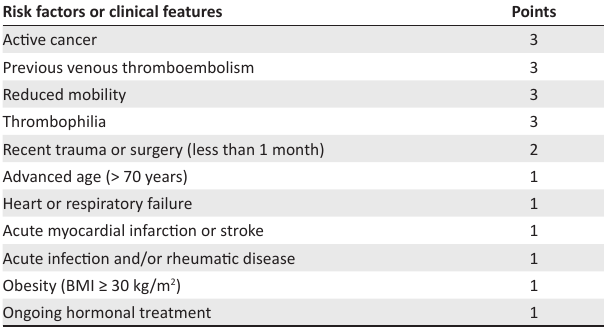
TABLE 2: The Padau prediction scoring